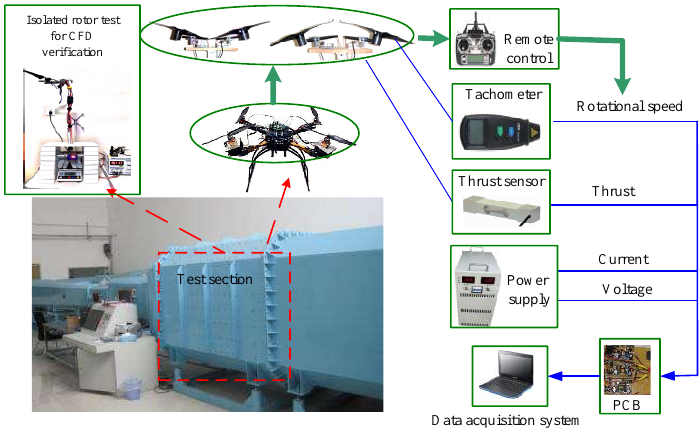
Figure 15. Experimental setup.